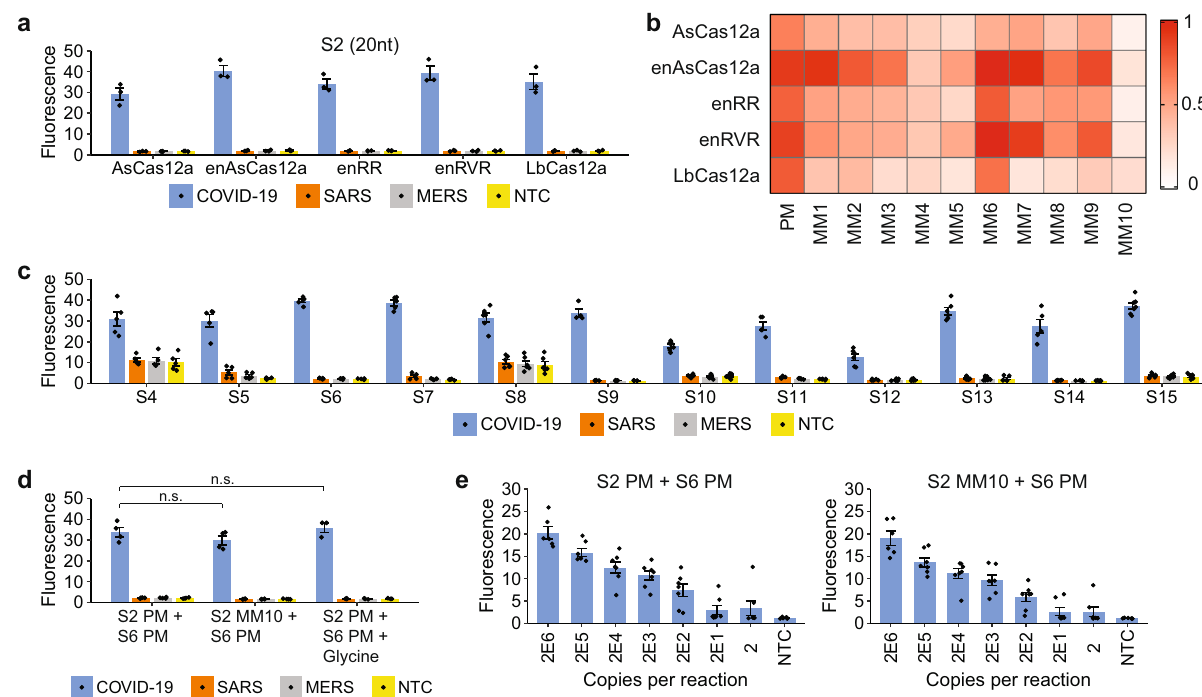
Fig. 2 Activity and mismatch tolerance of enAsCas12a with various S-gene-targeting gRNAs. a Fluorescence measurements for a single S2 gRNA complexed with various Cas12a nucleases after 30 min of trans -cleavage reaction at 37 °C. Compared to the earlier results obtained at 24 °C, there was still no cross-reactivity for SARS-CoV or MERS-CoV at the higher temperature, but the fl uorescence signal for SARS-CoV-2 was approximately twice as high. Data represent mean ± s.e.m. ( n = 3 biological replicates). b Heatmap showing the tolerance of various Cas12a enzymes to mismatches at the S2 target site when the trans -cleavage assay was performed at 37 °C. The fl uorescence readings are scaled between 0 and 1, where 1 is the highest measurement obtained and 0 is the background signal for NTC at the start of the experiment. c Fluorescence measurements for enAsCas12a complexed with different gRNAs targeting the S-gene of SARS-CoV-2 after 30 min of cleavage reaction at 37 °C. 1E11 copies of DNA were present in a 50 μ l reaction. Two of the gRNAs (S4 and S8) triggered the collateral activity of enAsCas12a without a template. Data represent mean ± s.e.m. ( n = 4 [S9], 5 [S4, S5, S6, S7, S11, S14], 6 [S8, S10, S12, S13], or 7 [S15] biological replicates). d Buffering the collateral activity of enAsCas12a against SNVs with a second gRNA. Fluorescence measurements here were taken after 30 min of cleavage reaction at 37 °C. The S6 gRNA was used together with either the perfect matched (PM) or a mismatched (MM10) S2 gRNA in the absence or presence of 0.1 M glycine. Data represent mean ± s.e.m. ( n = 3 [with glycine] or 4 [no glycine] biological replicates). (n.s. not signi fi cant, P > 0.2; two-sided Student ’ s t -test). e Analytical limit of detection (LoD) for enAsCas12a complexed with